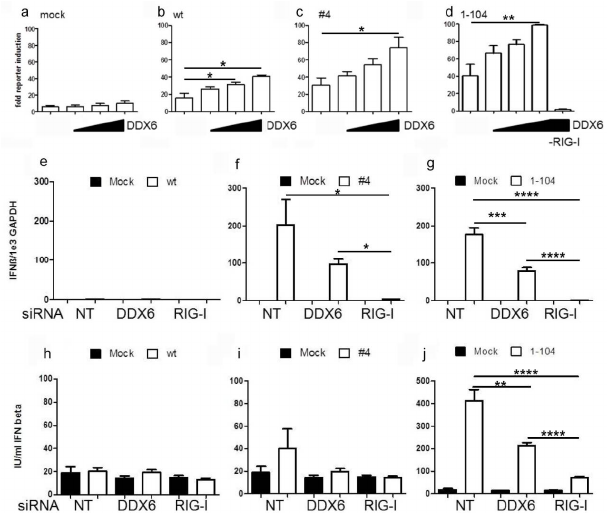
Figure 3. DDX6 promotes RIG-I mediated IFN-β induction. 293T cells co-transfected with Flag-RIG-I,